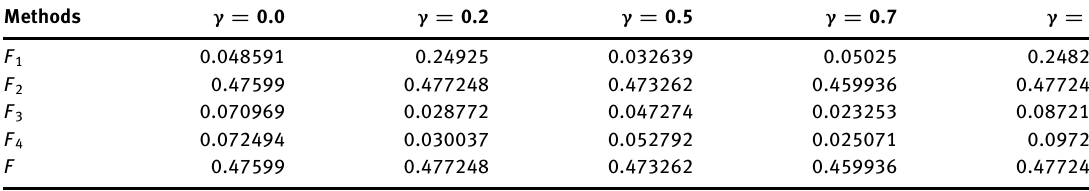
Table 5: Effect of Varying γ Using the T10